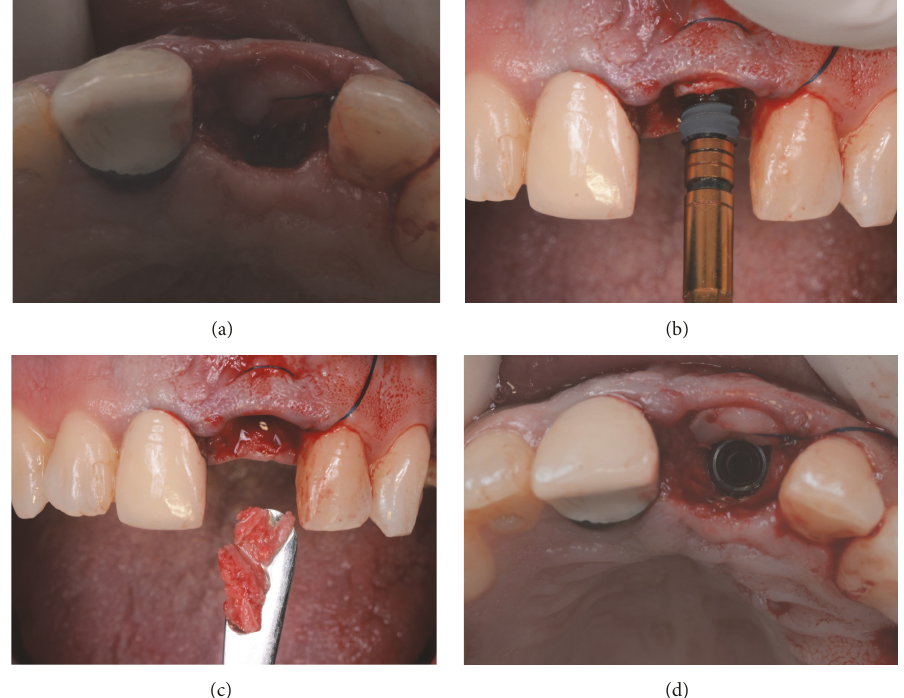
Figure 4: Surgery. The connective tissue graft is secured in position, within the envelope flap (a); then the implant (Anyridge, Megagen) is inserted slightly subcrestal and in palatal position (b); the autogenous bone chips collected during the preparation of the implant site are then placed in the alveolus (c), in order to fill the gaps between the socket and the implant